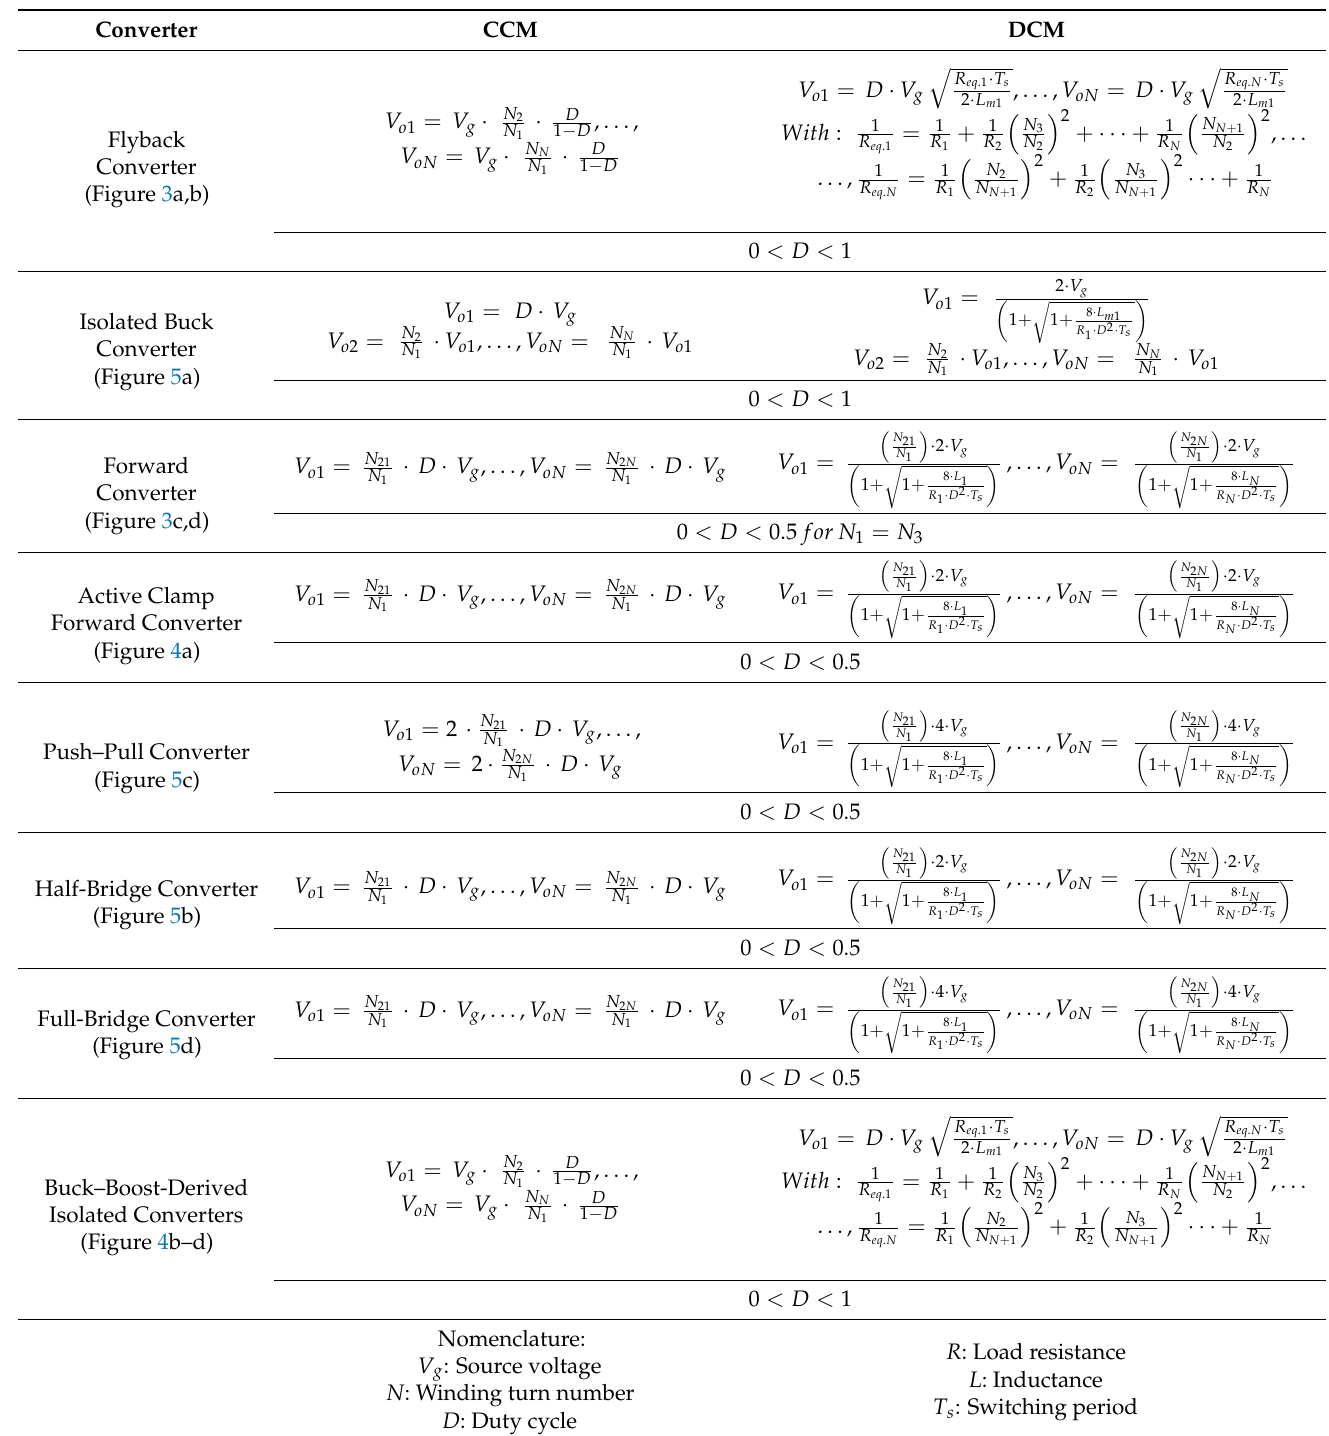
Table 1. Conversion relations for Multiple-Output Isolated DC–DC